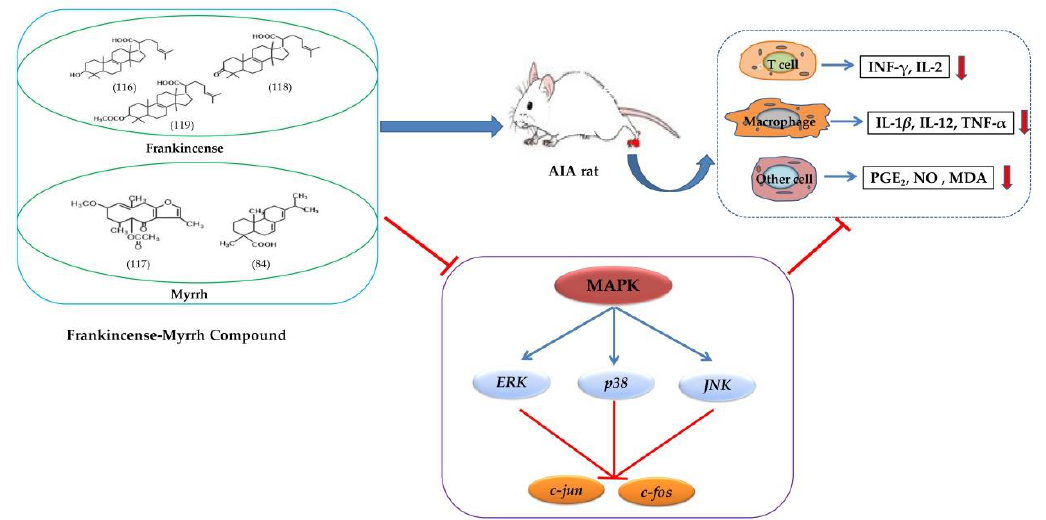
Figure 6. Illustration of frankincense–myrrh compound in the treatment of adjuvant-induced arthritis (AIA) in rats. The bioactive components of frankincense and myrrh significantly reduced the expression levels of inflammatory cytokines INF- γ , IL-2, IL-1 β , IL-12, TNF- α , PGE 2 , NO, and MDA in AIA rats’ serum and foot swelling by reducing the phosphorylation of three kinds of MAPK (ERK, p38, and JNK) and the down-regulation of downstream genes ( c-jun and c-fos ).